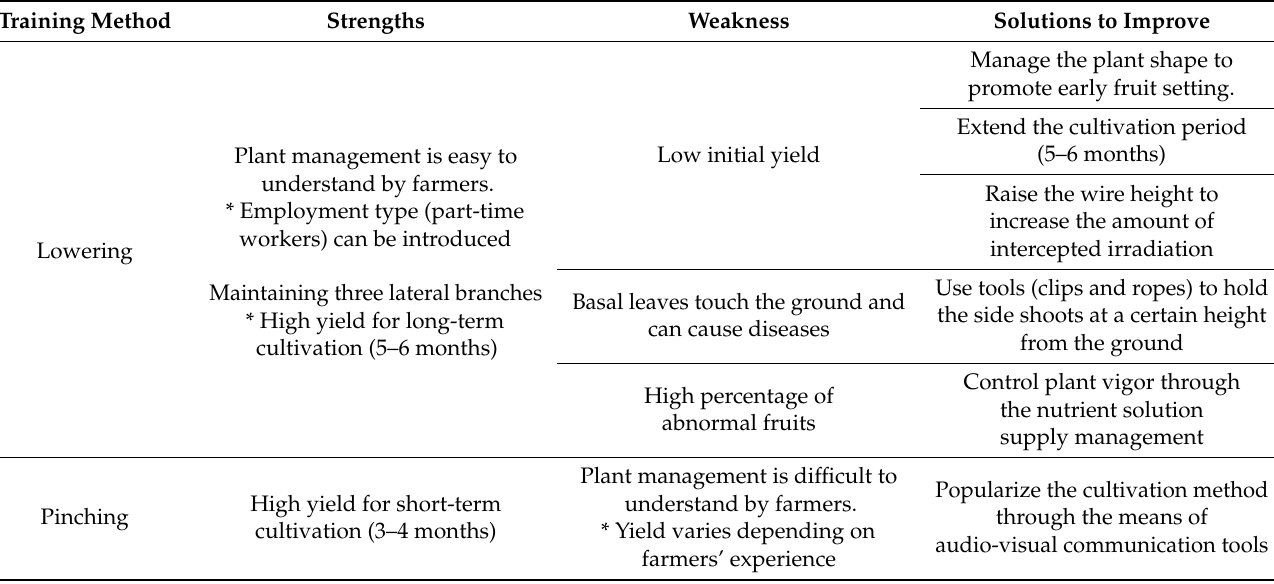
Table 9. Strengths and weaknesses of training methods and how to improve